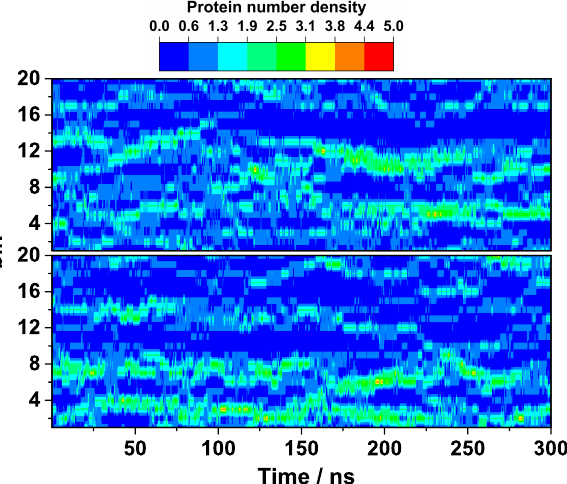
Figure 9. Density fluctuation of HEWL solution containing 0.3 M arginine with different force fields, namely OPLS ( top ) and CHARMM27 ( bottom ), in the x-axis